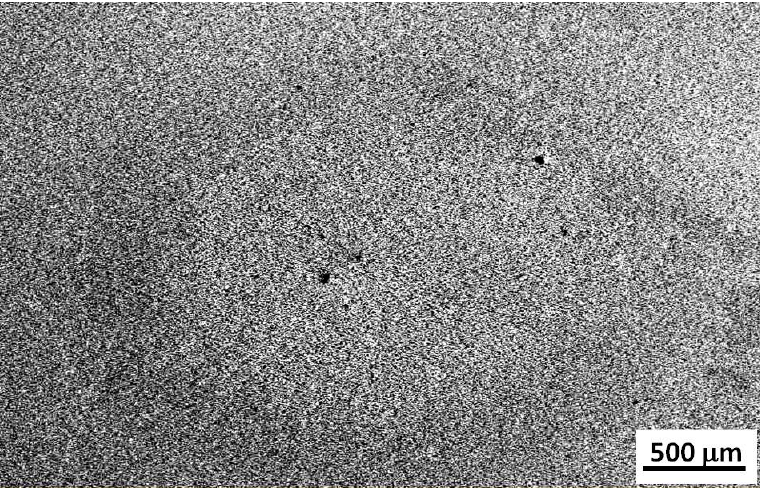
Figure 5. SEM micrograph a low magnification of the area affected by laser pulse.